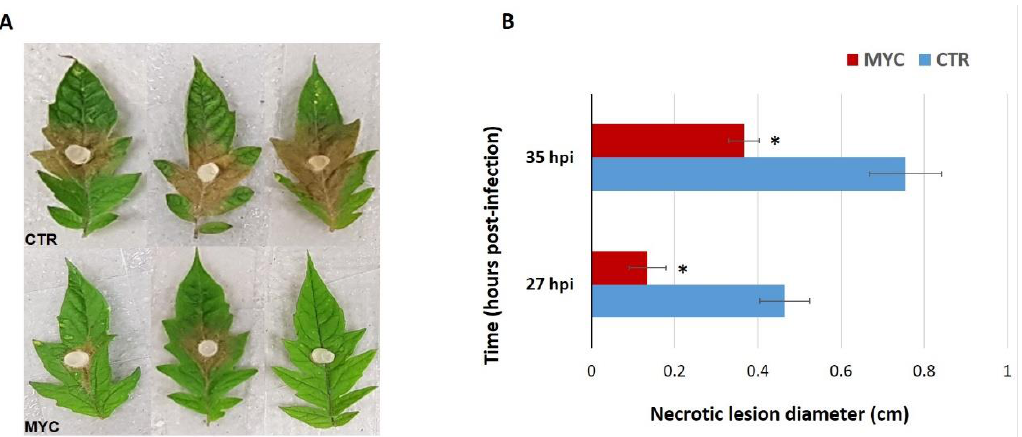
Figure 1. Mycorrhiza-induced resistance in tomato leaves. ( A ) S. sclerotiorum infection on tomato leaves estimated by measuring the diameter of the necrotic lesion on MYC and CTR plants at 35 hpi (hours post-infection). ( B ) Diameter of lesions caused by S. sclerotiorum on leaves of MYC and CTR tomato after 27 and 35 hpi. CTR, non-colonized plants; MYC, AM-plants colonized with Rhizophagus irregularis . (*) indicates significantly different means between CTR and MYC per time point (Student’s t -test, p ≤ 0.05, n = 5). Bars, ±SE.